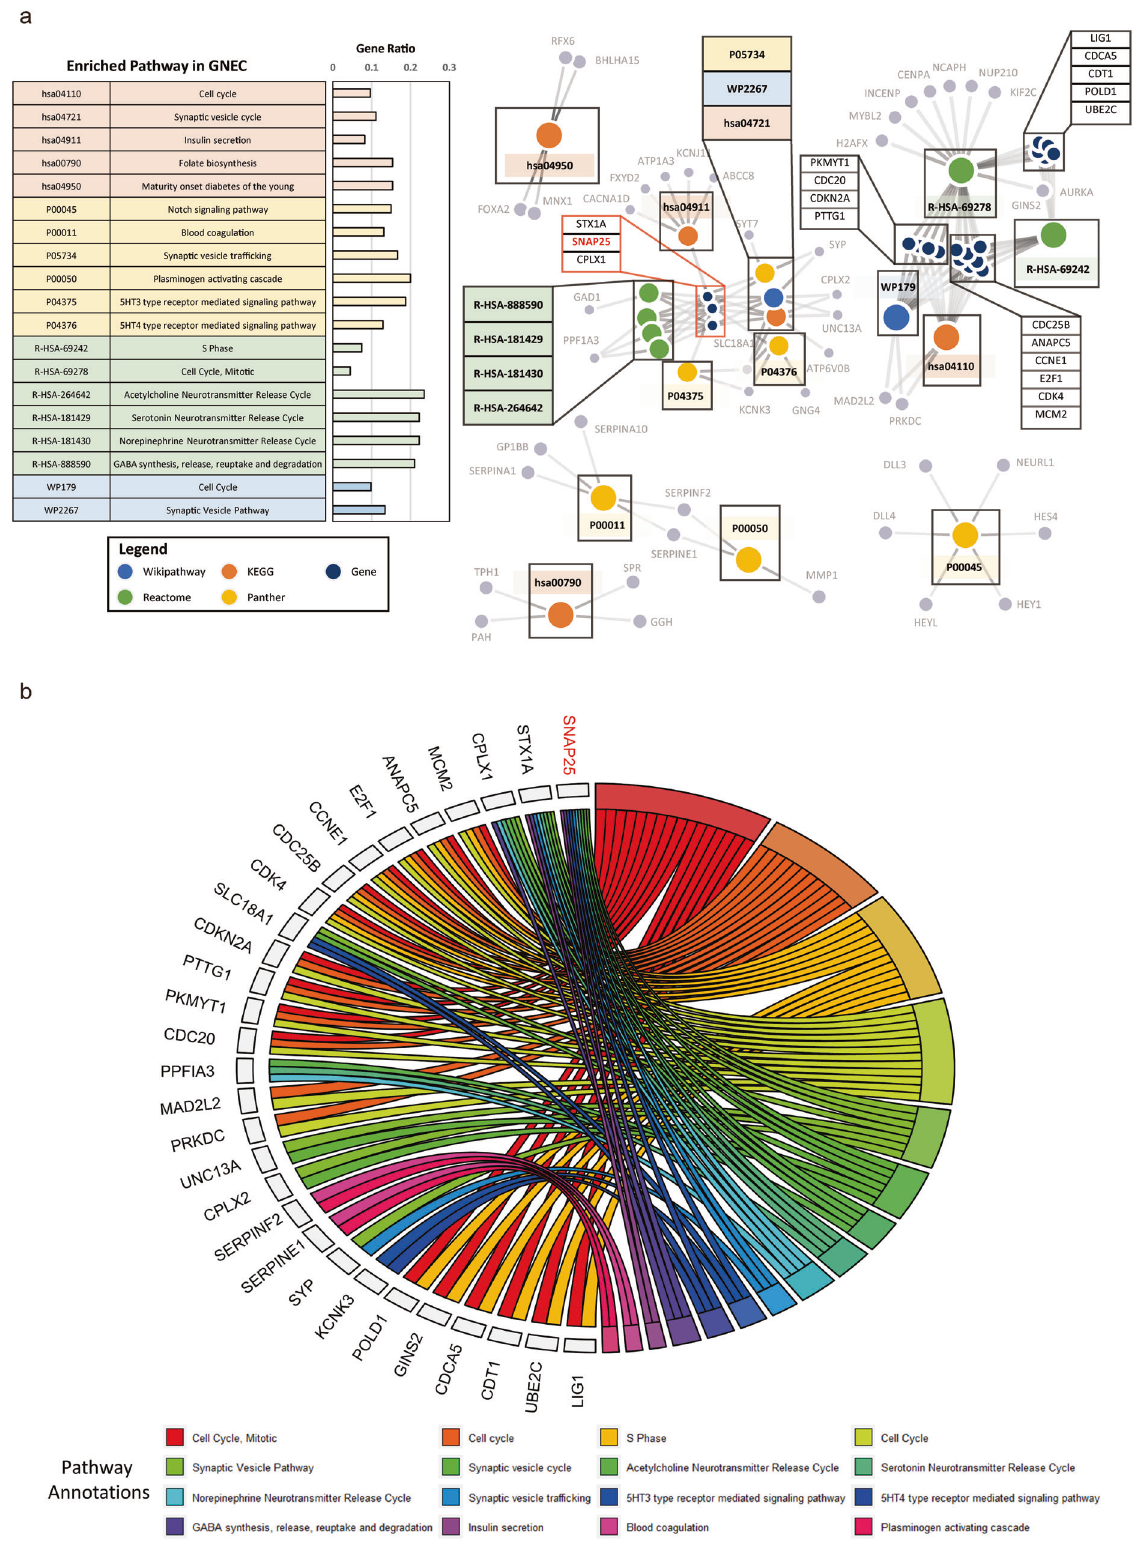
Fig. 2 Pathway Enrichment Pattern of DEGs in GNEC patient samples. a Overrepresentative analyses revealed 19 pathways that were signi fi cantly enriched in GNEC. b Sixteen enriched pathway annotations were processed using a GOChord plot. Common genes (found in at least two pathway annotations) are listed on the left side, and enriched pathway annotations are listed on the right side.